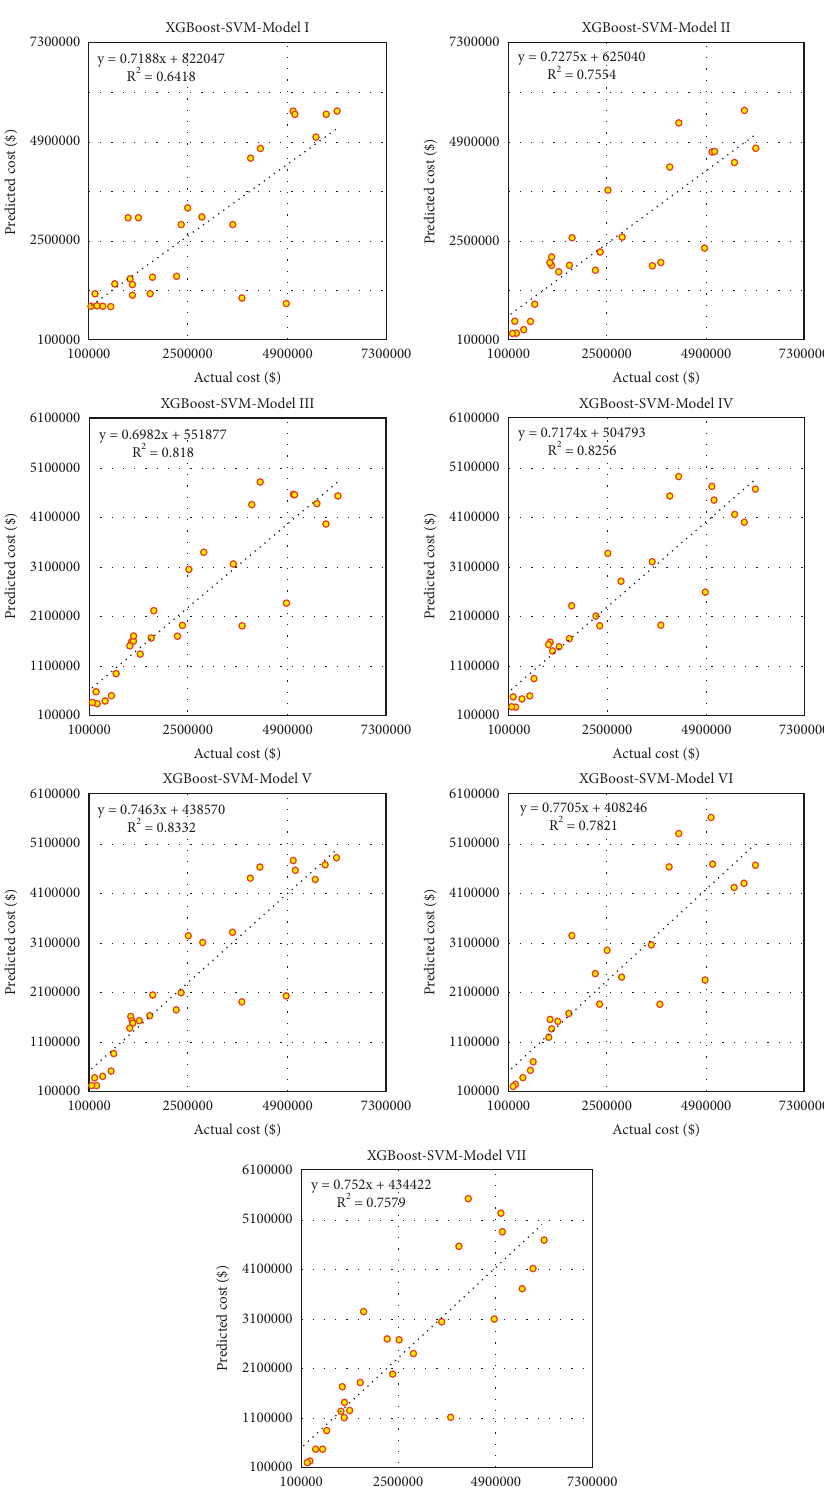
Figure 8: Scatter plot presentation of the XGBoost-SVM model for tested Table 4. The XGBoost-ANN-Model revealed the poorest results of Model I with high residual errors and the farthest distance to actual cost (see Figures 9 and 10). In the case of the SVM model, three models (i.e., Model III, Model IV, and